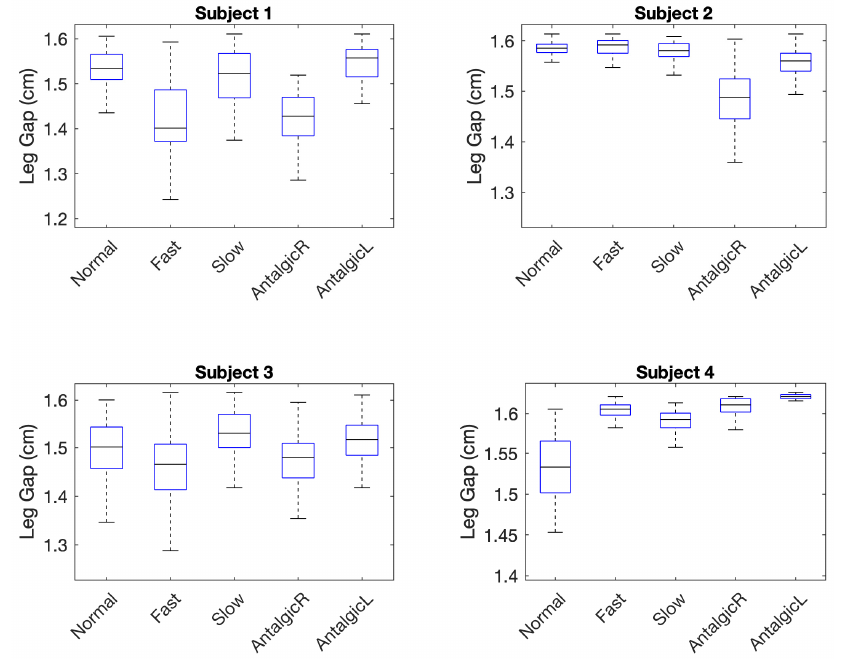
Figure 5. Boxplots indicating Leg Gap Variability for Four Subjects.